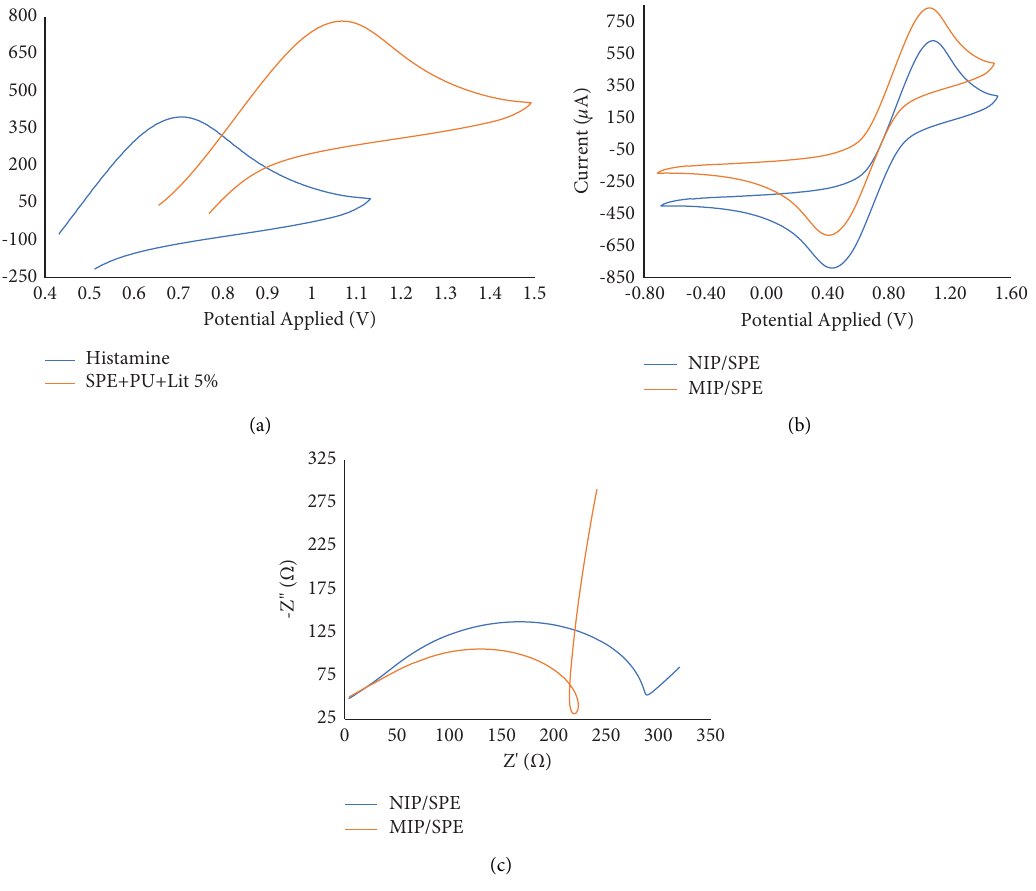
Figure 3: (a) Cyclic voltammograms of the modifed electrode without histamine (SPE+ PU+Lit 5%) and modifed electrode that contains histamine to examine the potential application of histamine in 100mmol · L − 1 PBS; (b) the cyclic voltammograms of NIP/SPE and MIP/SPE using lithium perchlorates (5%) in 100mmol · L − 1 PBS; and (c) the spectra of the impedance of NIP/SPE and MIP/SPE in PBS (100mmol · L − 1